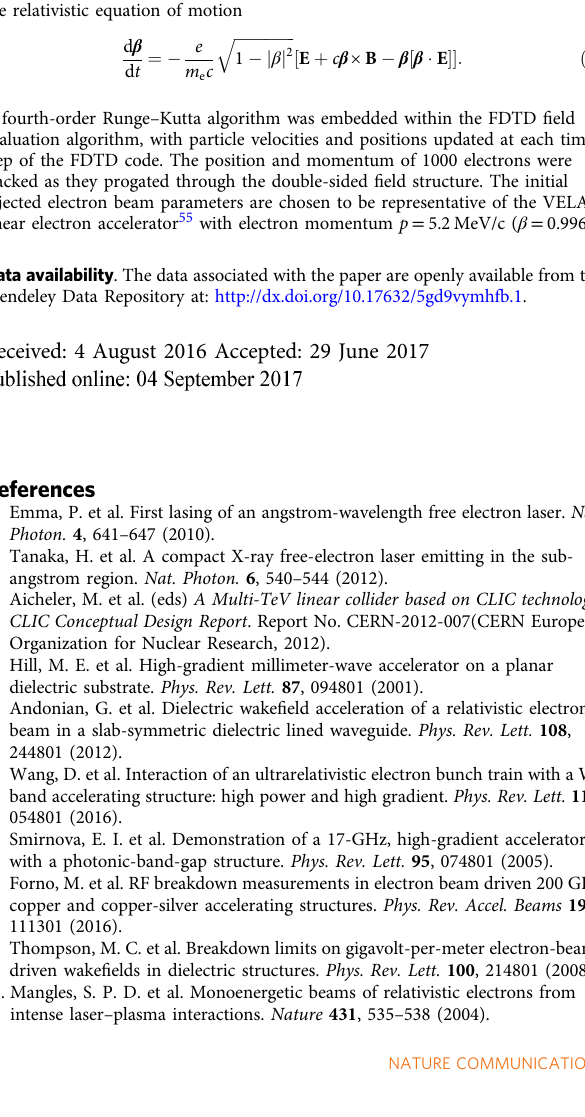
A fourth-order Runge – Kutta algorithm was embedded within the FDTD fi eld evaluation algorithm, with particle velocities and positions updated at each time